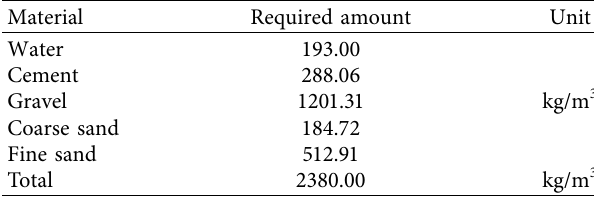
Table 2: Design of a concrete mix for 1m 3